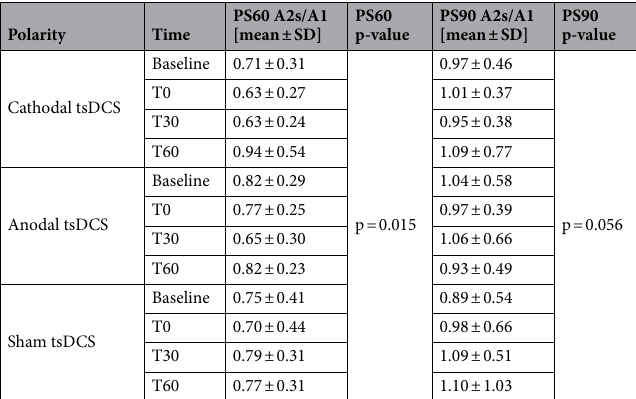
Table 3. Amplitude ratios of paired stimulations. Ratios of the P40-N50 peaks (A2s/A1) of paired stimulations with an interstimulus interval of 60 (PS60) and 90 ms (PS90) (mean ± SD). SEPs were recorded before (baseline), immediately (T0) as well as 30 (T30) and 60 min (T60) after tsDCS. P-values were calculated using a Greenhouse–Geisser-corrected rmANOVA for polarity*time; n =